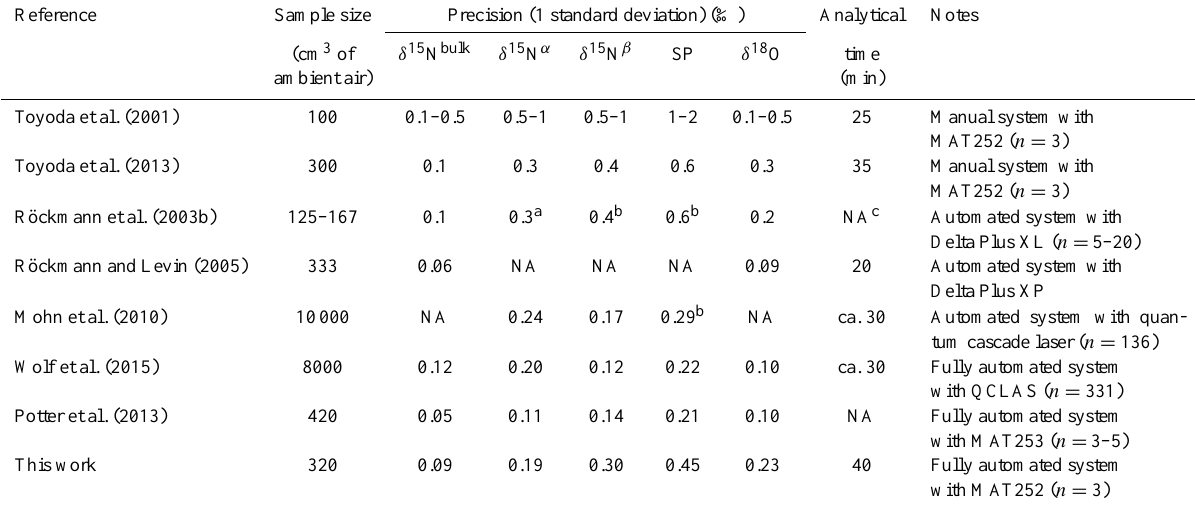
Table 1. Comparison of the analytical precision obtained in this study and those values reported in the literature. Reference Sample size Analytical Notes